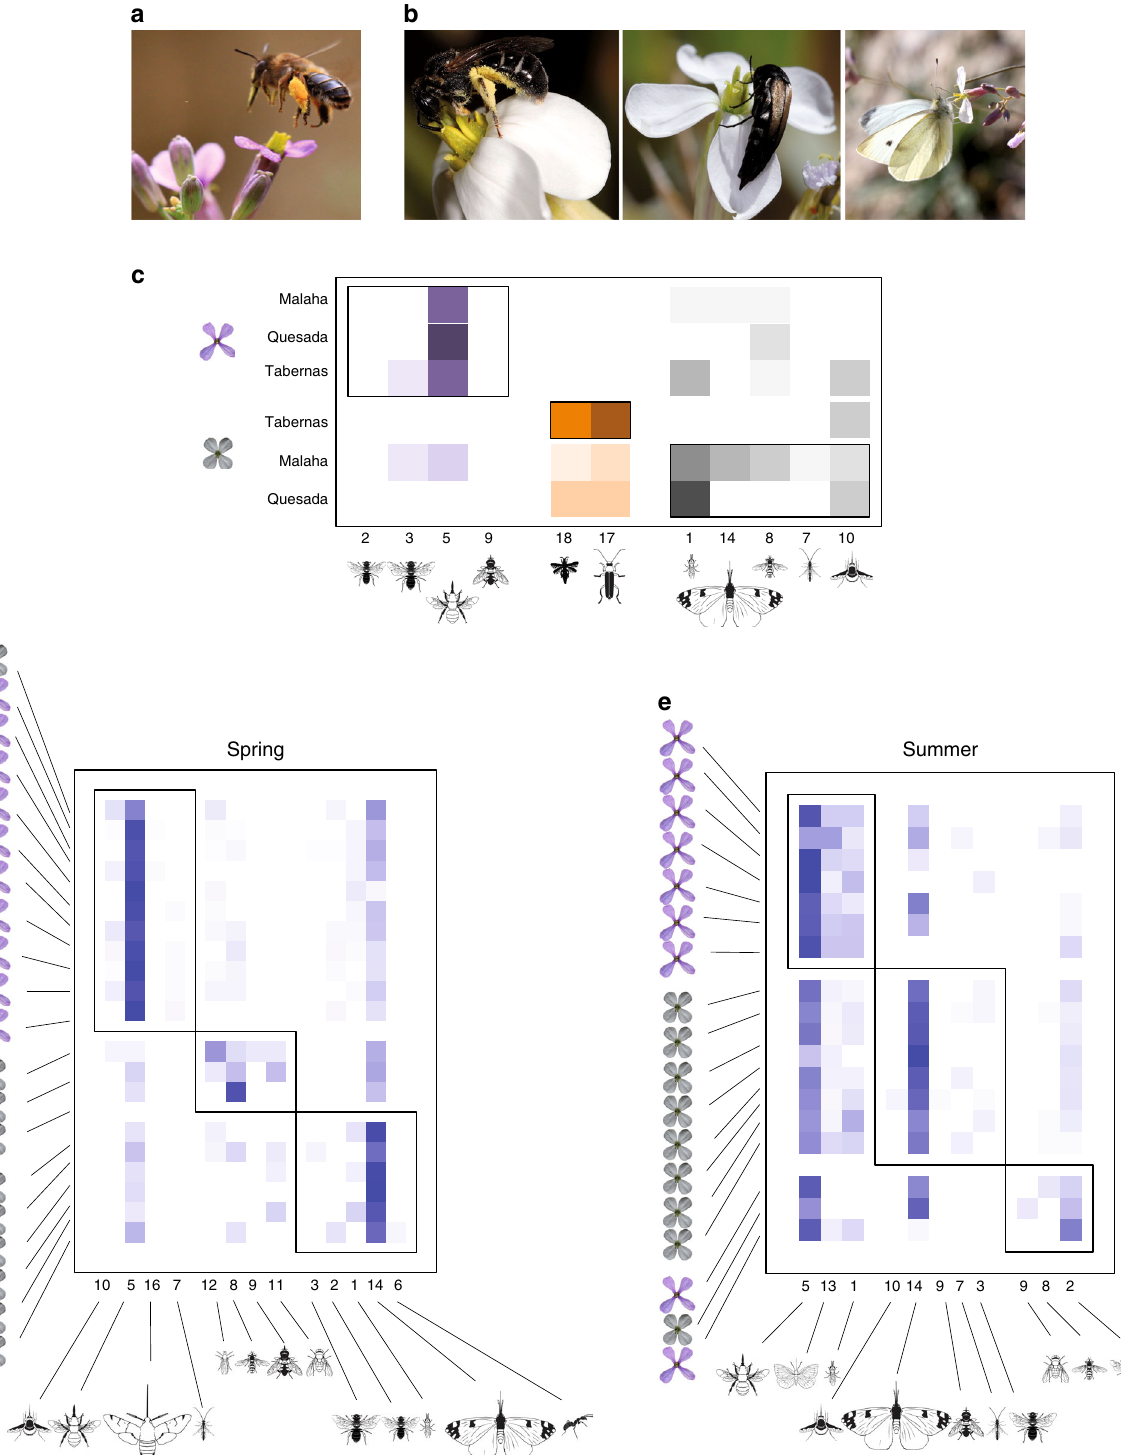
Fig. 5 Seasonal changes in pollination niche. a Main pollinator of spring fl owers: long-tongued bee ( Anthophora sp.). b Main pollinators of summer fl owers: small bee ( Lasioglossum sp.), small beetle ( Mordellistena sp.) and butter fl y ( Pieris sp.) (photographs taken by F. Perfectti). Outcome of the modularity analysis of the pollination networks built upon the visitation rate of the main pollinator functional groups c to three M. arvensis populations during summer and spring; d to experimental plants displaying spring fl owers and summer fl owers during spring in the fi eld; e to experimental plants displaying spring fl owers and summer fl owers during summer in the fi eld. Pollinator Functional Groups: 1. short-tongued small bees; 2. short-tongued medium-sized bees; 3. short-tongued large bees; 5. long-tongued large bees; 6. ants; 7. small wasps; 8. small hover fl ies; 9. large hover fl ies; 10. bee fl ies; 11. large fl ies; 12. long-tongued small fl ies; 13. small butter fl ies; 14. large butter fl ies; 16. hawkmoths; 17. beetles; 18. trips. Insect silhouettes drawn by Divulgare (www.divulgare.net) under a